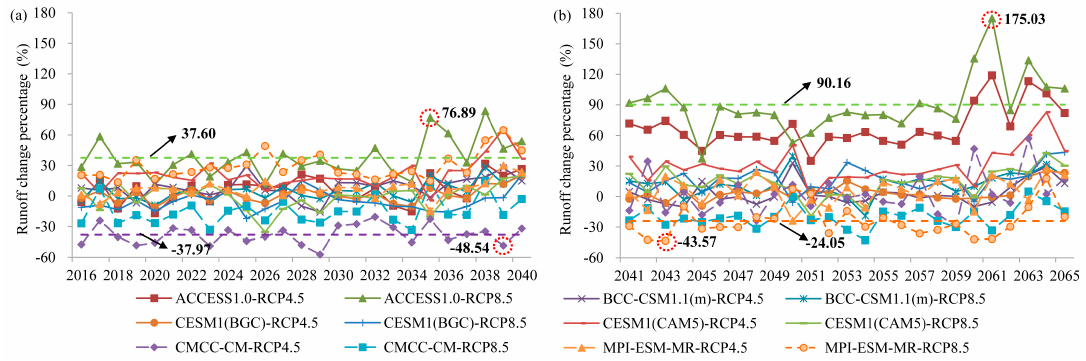
Figure 14. The forecasted runoff change percentage relative to 1980–2004 period under CMIP5: ( a ) 2016–2040; ( b ) 2041–2065.